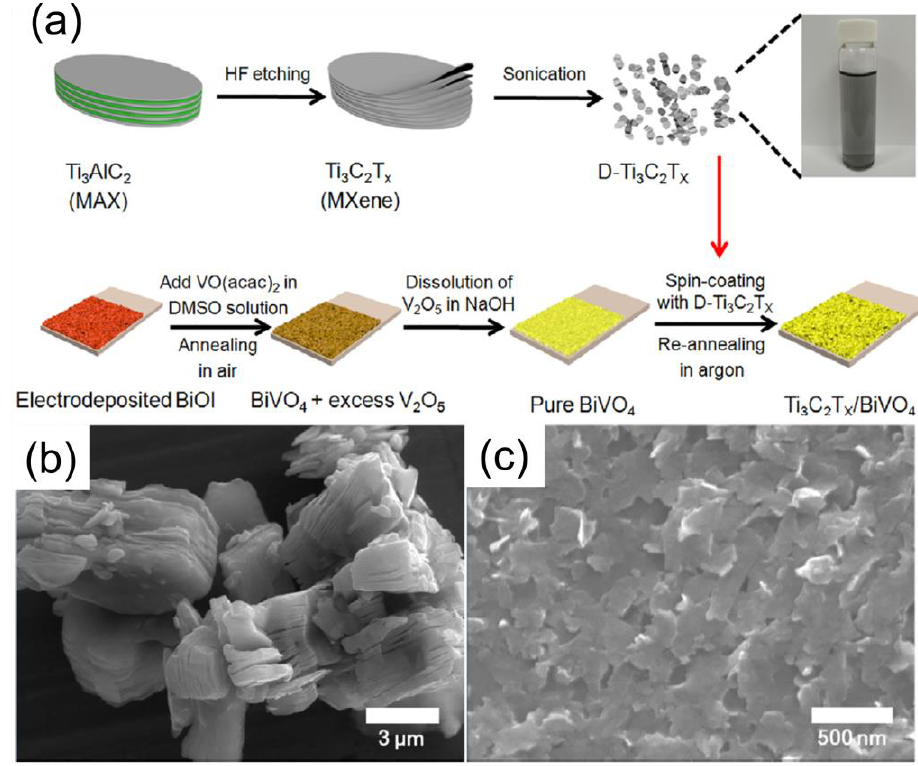
Figure 10. ( a ) Schematic description for the synthesis of M-Mxene/BiVO 4 composites and ( b , c ) TEM images of M-MXene/BiVO 4 . (Reprinted with permission from Ref. [159]. 2019 Elsevier). Table 7. Summary of BiVO 4 -MXene based photocatalysts synthesis technique.